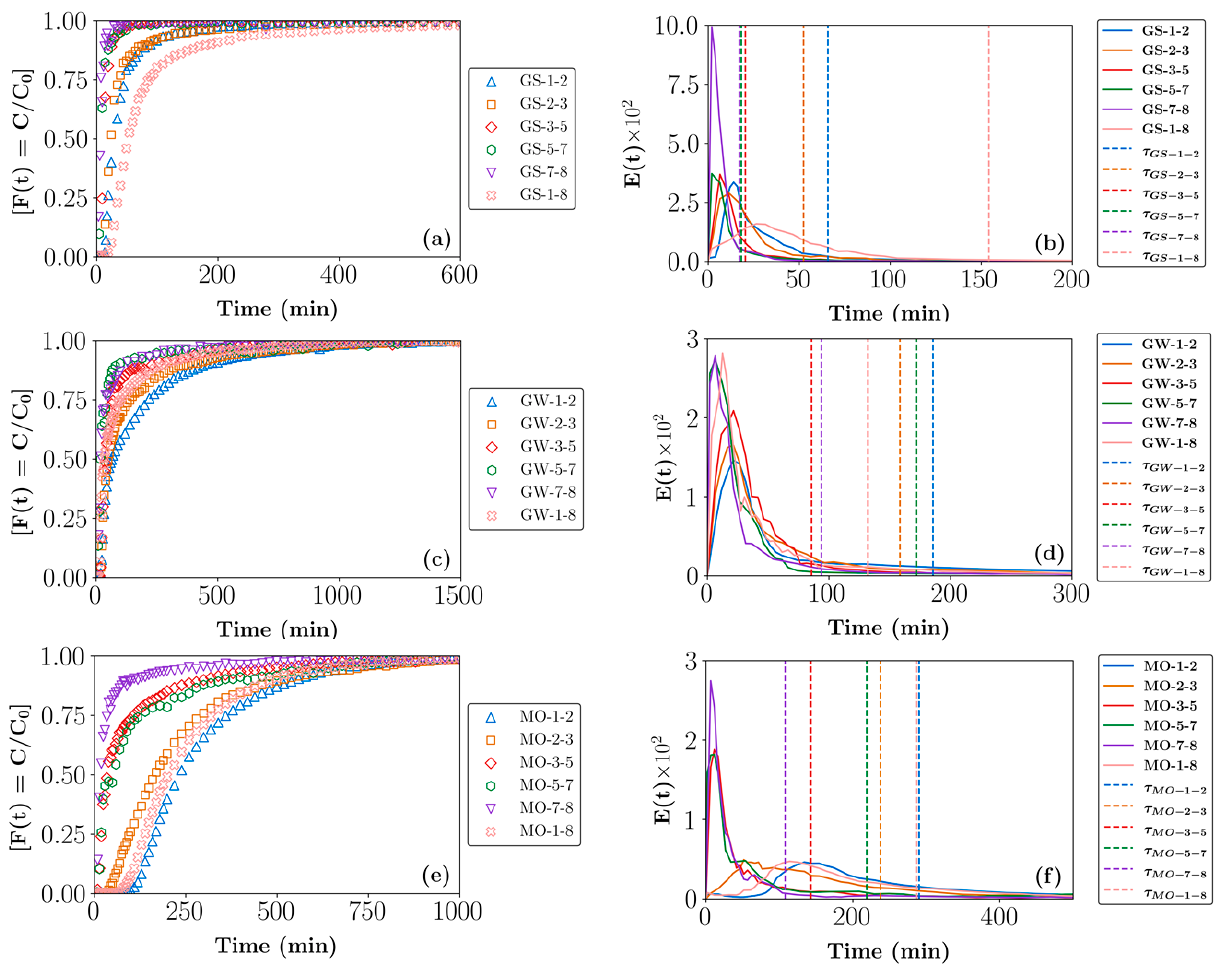
Figure 11. (Left—( a , c , e )) Cumulative (F(t)) and (right—( b , d , f )) exit age (E(t)) RTD profiles for beds composed of different size fractions of glass shards (GSs), greywacke (GW), and malachite ore (MO). The vertical lines in the E(t) curves represent the calculated average residence times. Key: GS/GW/MO- 1-2 (1–2 mm), 2-3 (2–2.8 mm), 3-5 (2.8–4.8 mm), 5-7 (4.8–6.7 mm), 7-8 (6.7–8 mm), and 1-8 (1–8